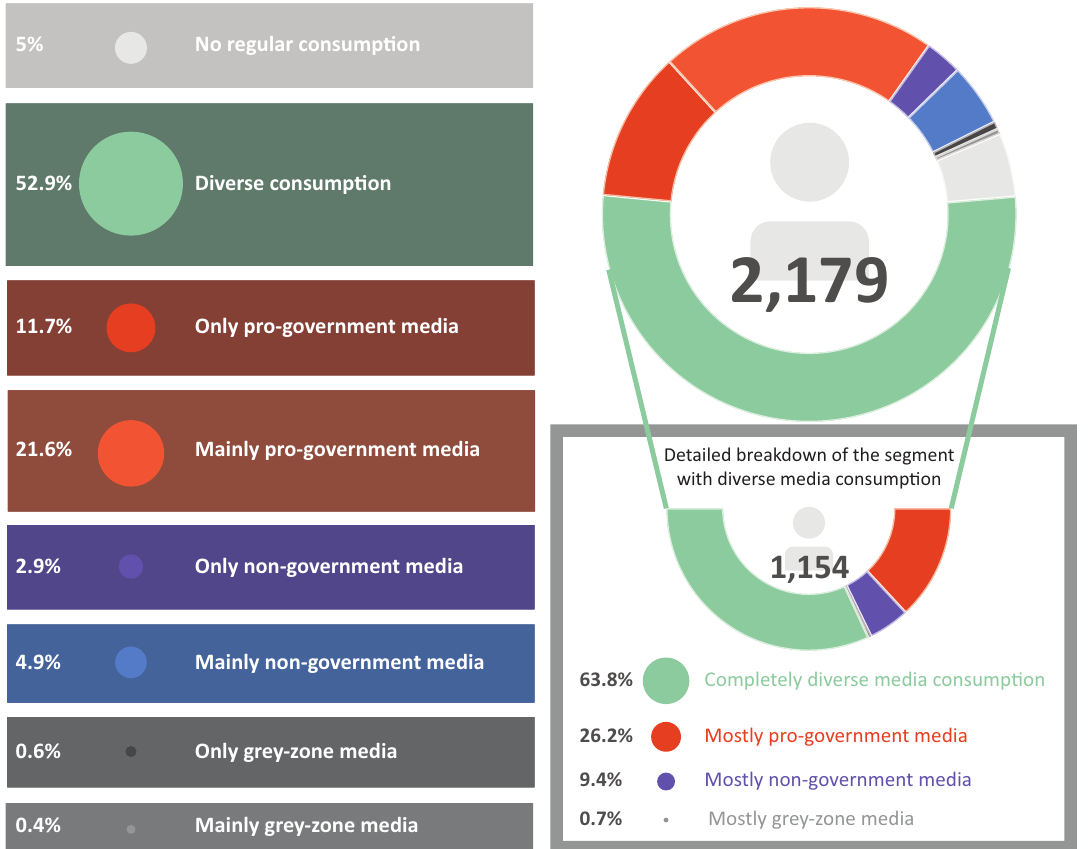
Figure 2. Consumption patterns in the three‐tier classification scheme. 20% of the total sample’s regular news